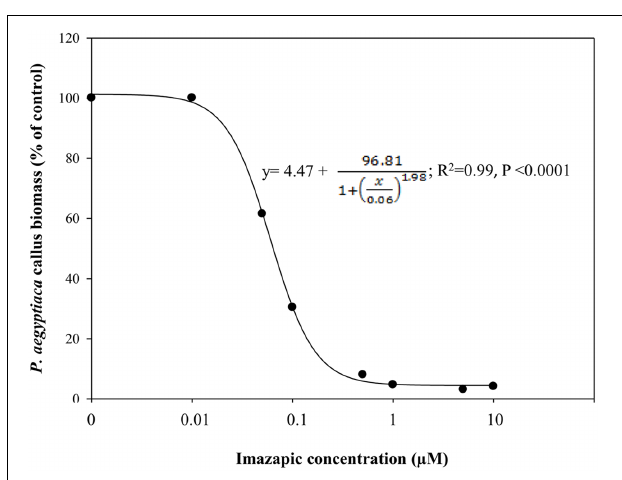
FIGURE 4 | Biomass accumulation of P. aegyptiaca callus grown on BCGM containing imazapic. The experiment was conducted with eight replicates. The data were computed by non-linear regressions using Sigma-Plot version 11.01. y = y 0 + a